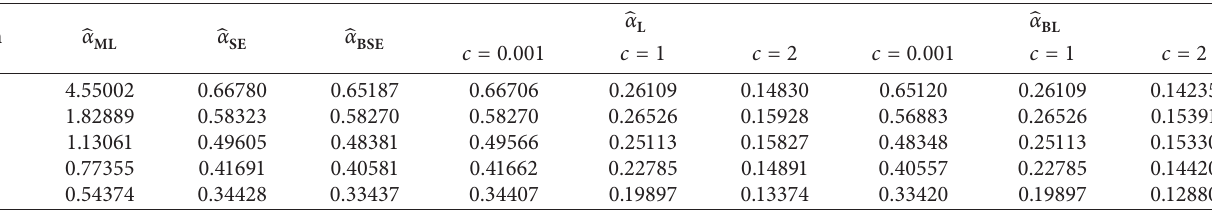
Table 2: MSEs of the estimates of α